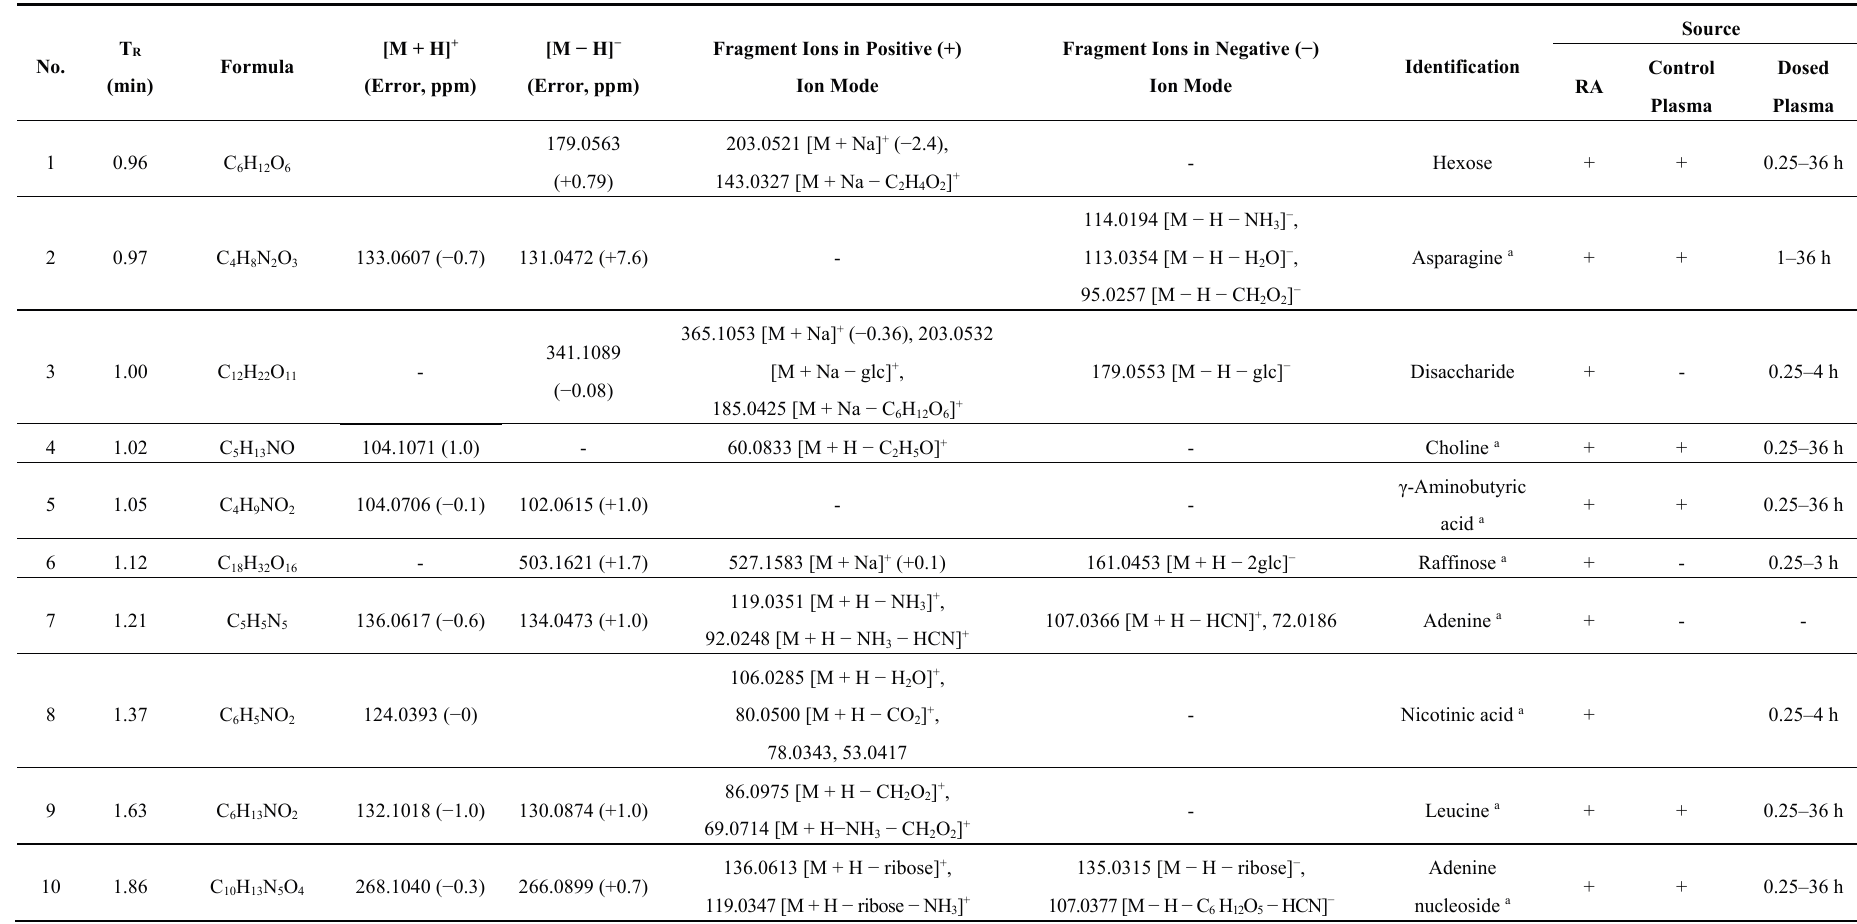
Table 1. LC-DAD-TOF-MS/MS data for the identification of multiple constituents in Radix Astragali (RA) extract, absorbed compounds and metabolites in immunosuppressed mice